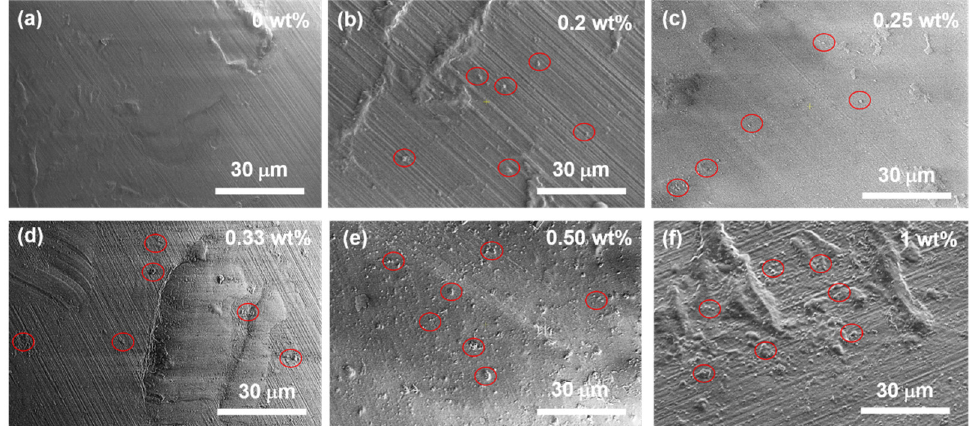
Figure 2. SEM images of the MDP composites based on green daylight resin with ( a ) 0 wt.% (green polymer), ( b ) 0.2 wt.%, ( c ) 0.25 wt.%, ( d ) 0.33 wt.%, ( e ) 0.5 wt.%, and ( f ) 1 wt.% of MDPs content (0 wt.% belongs to the pure polymer without MDPs). MDPs and MDP aggregates are marked with red circles.